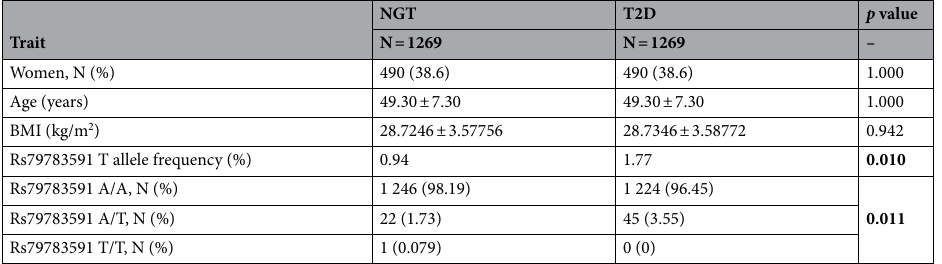
Table 3. General characteristics of Mexican adults with T2D and NGT matched for sex, age (range ± 0.5 years), and BMI (range ± 0.5 kg/m 2 ). Data are expressed as mean ± standard deviation. NGT normal glucose tolerance, T2D type 2 diabetes, BMI body mass index. The difference in sex ratios was analyzed using the X 2 test. Differences in means were analyzed using Student’s t-tests. Significant p values ( p < 0.05) are reported in bold.